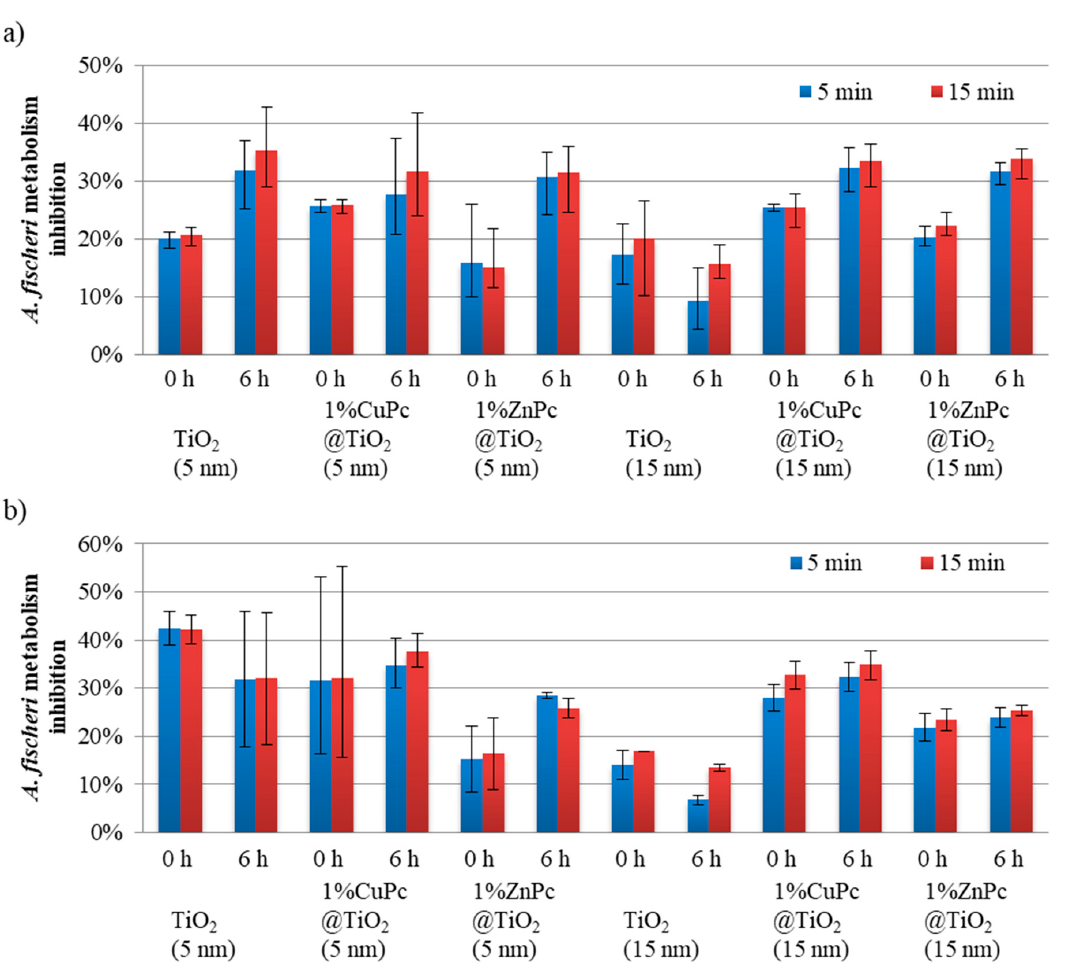
Figure 11. Cell viability decrease of A. fischeri cells upon addition of ibuprofen solutions before (0 h) and after (6 h) photodegradation experiment with different photocatalysts, when irradiated with ( a ) UV light ( λ max = 365 nm), ( b ) red light ( λ max = 665 nm).